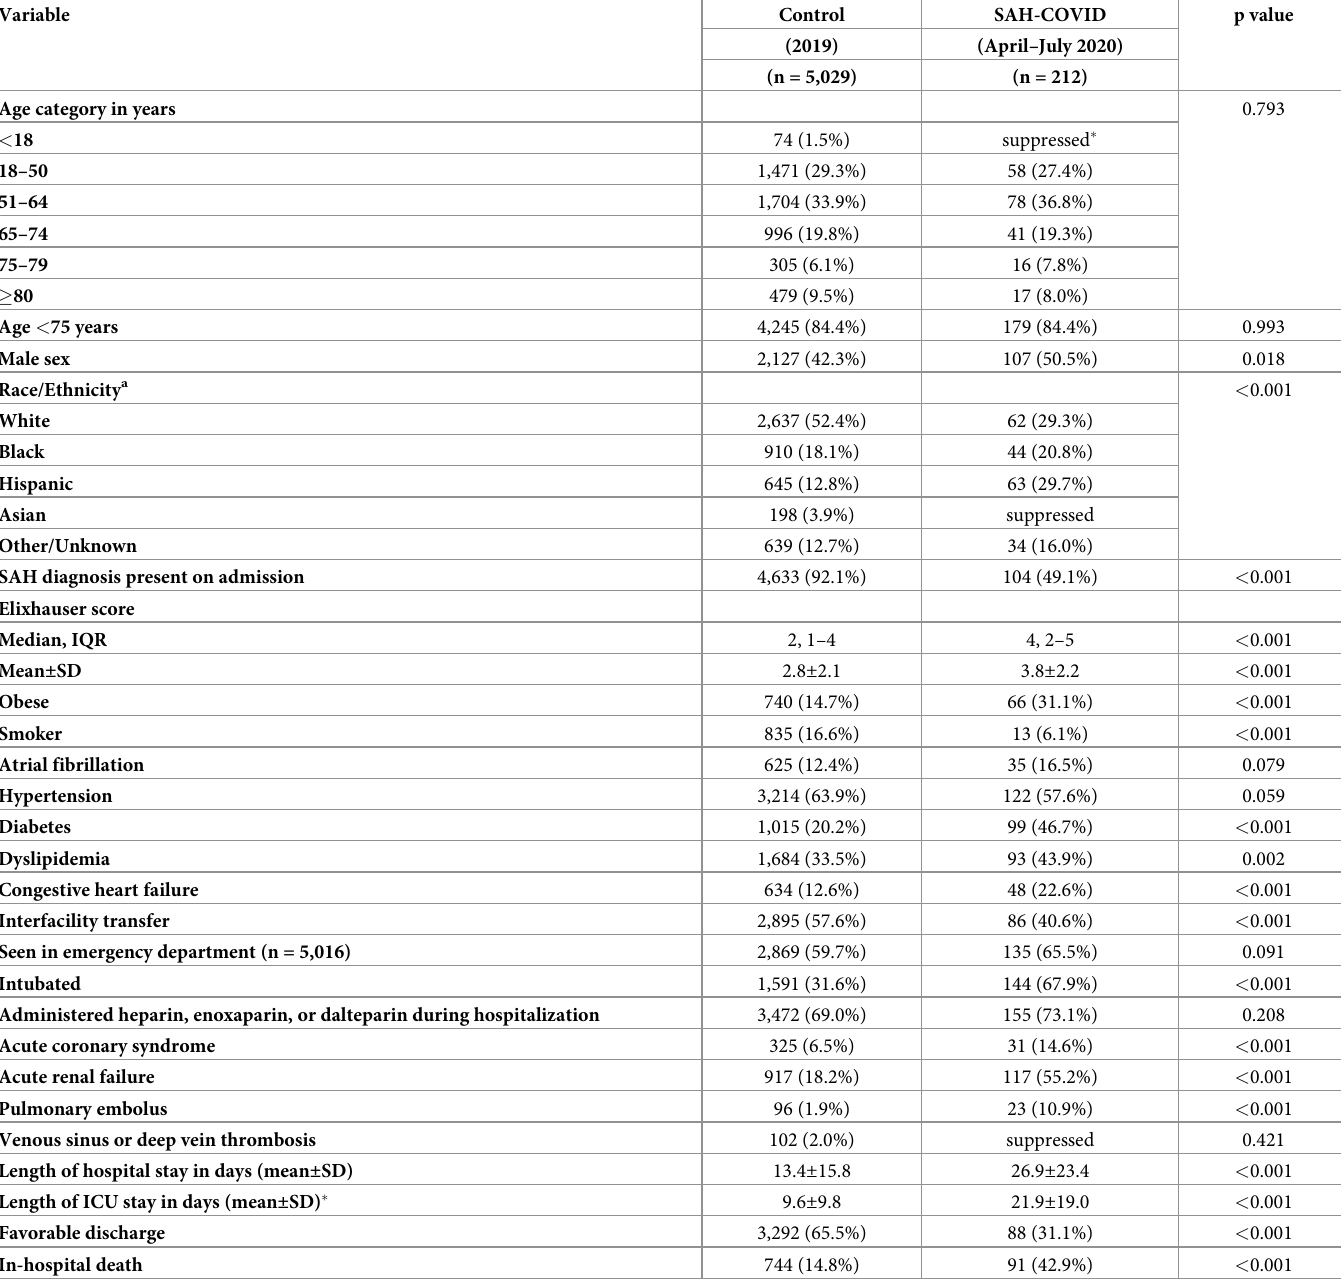
Table 3. Baseline demographics and outcomes of patients with subarachnoid